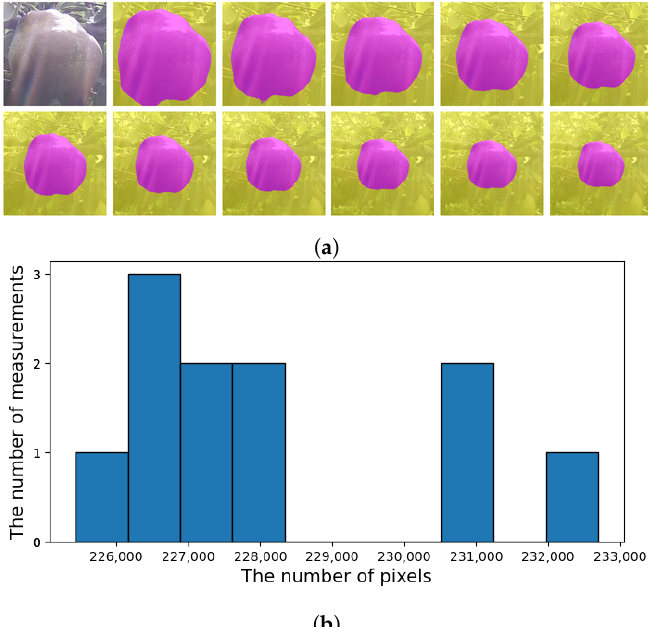
Figure 12. ( a ) CROP makes 11 measurements in different scale factors; from × 1.0 to × 0.5. ( b ) The median of re-scaled values will be picked to exclude outliers. The corresponding mask will be picked as in Figure 11d. The image ID is